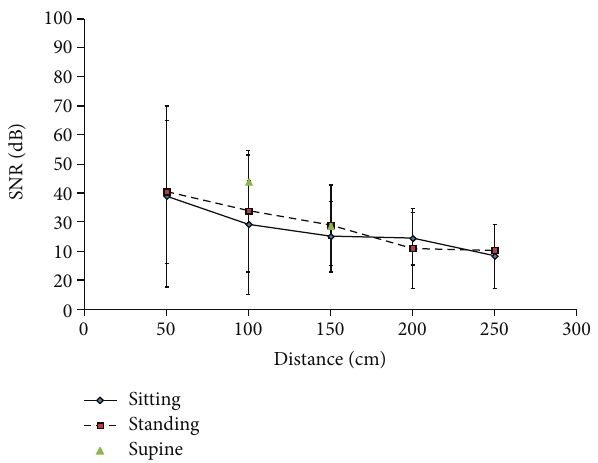
Figure 7: SNRs values (mean and standard deviation) in the function of 𝐷 and for each of the postures.